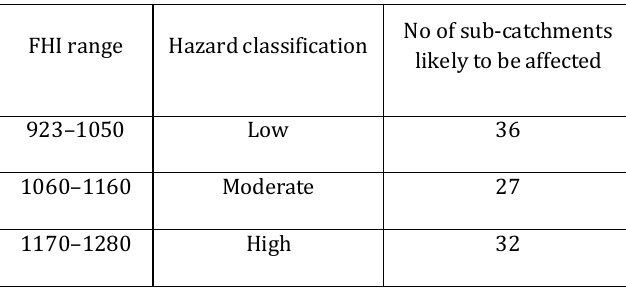
Table 6. Zones, which are affected by